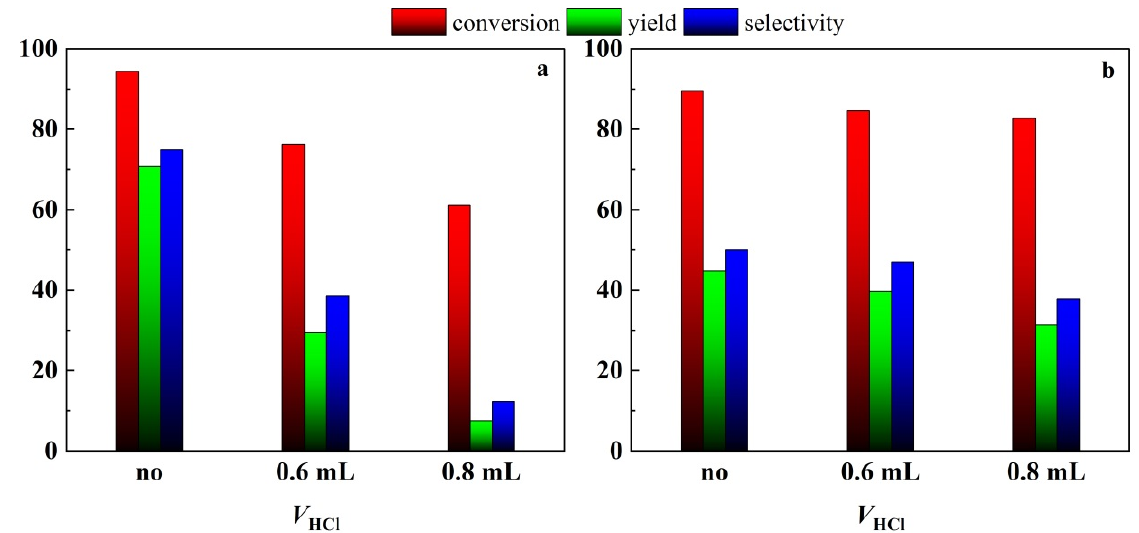
Figure 9. Decline of catalytic properties of UIO-66-NO 2 -25 for HMF production from ( a ) fructoseand ( b ) glucose after soaking.